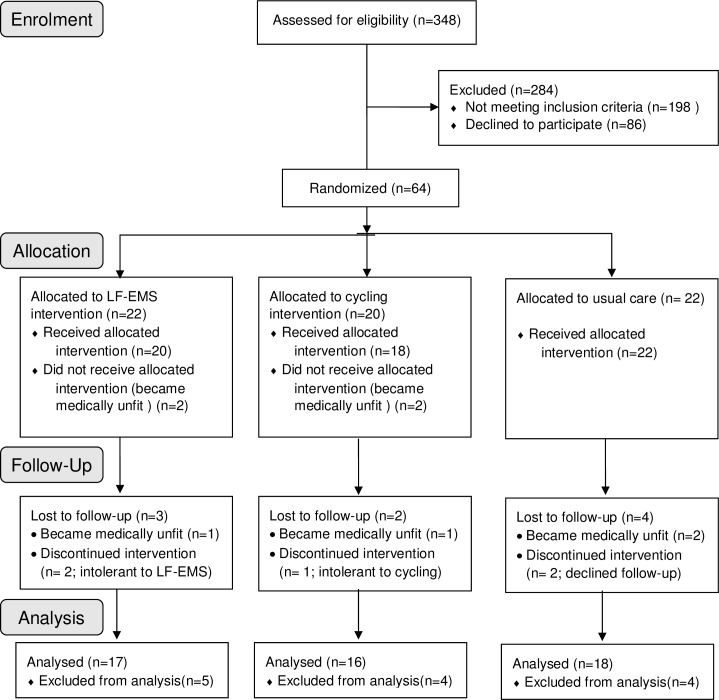
CONSORT (consolidated standards of reporting trials) diagram.LF-EMS, low frequency electrical muscle stimulation.